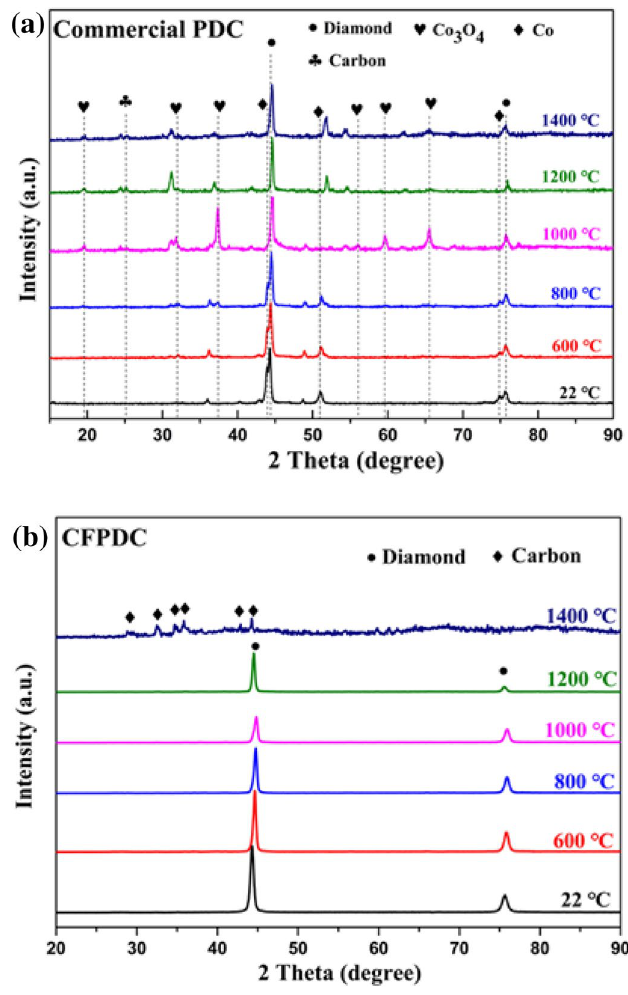
Figure 8. Thermal Stability and Oxidation Resistance. In-situ high temperature XRD patterns of commercial PDC and CFPDC samples at different temperatures ranging from 22 to 1400 °C in air, ( a ) Commercial PDC sample, ( b ) CFPDC sample The results of In-situ high temperature XRD indicate that the commercial PDC sample begins to oxidize at 600 °C, while CFPDC sample can be stable up to 1200